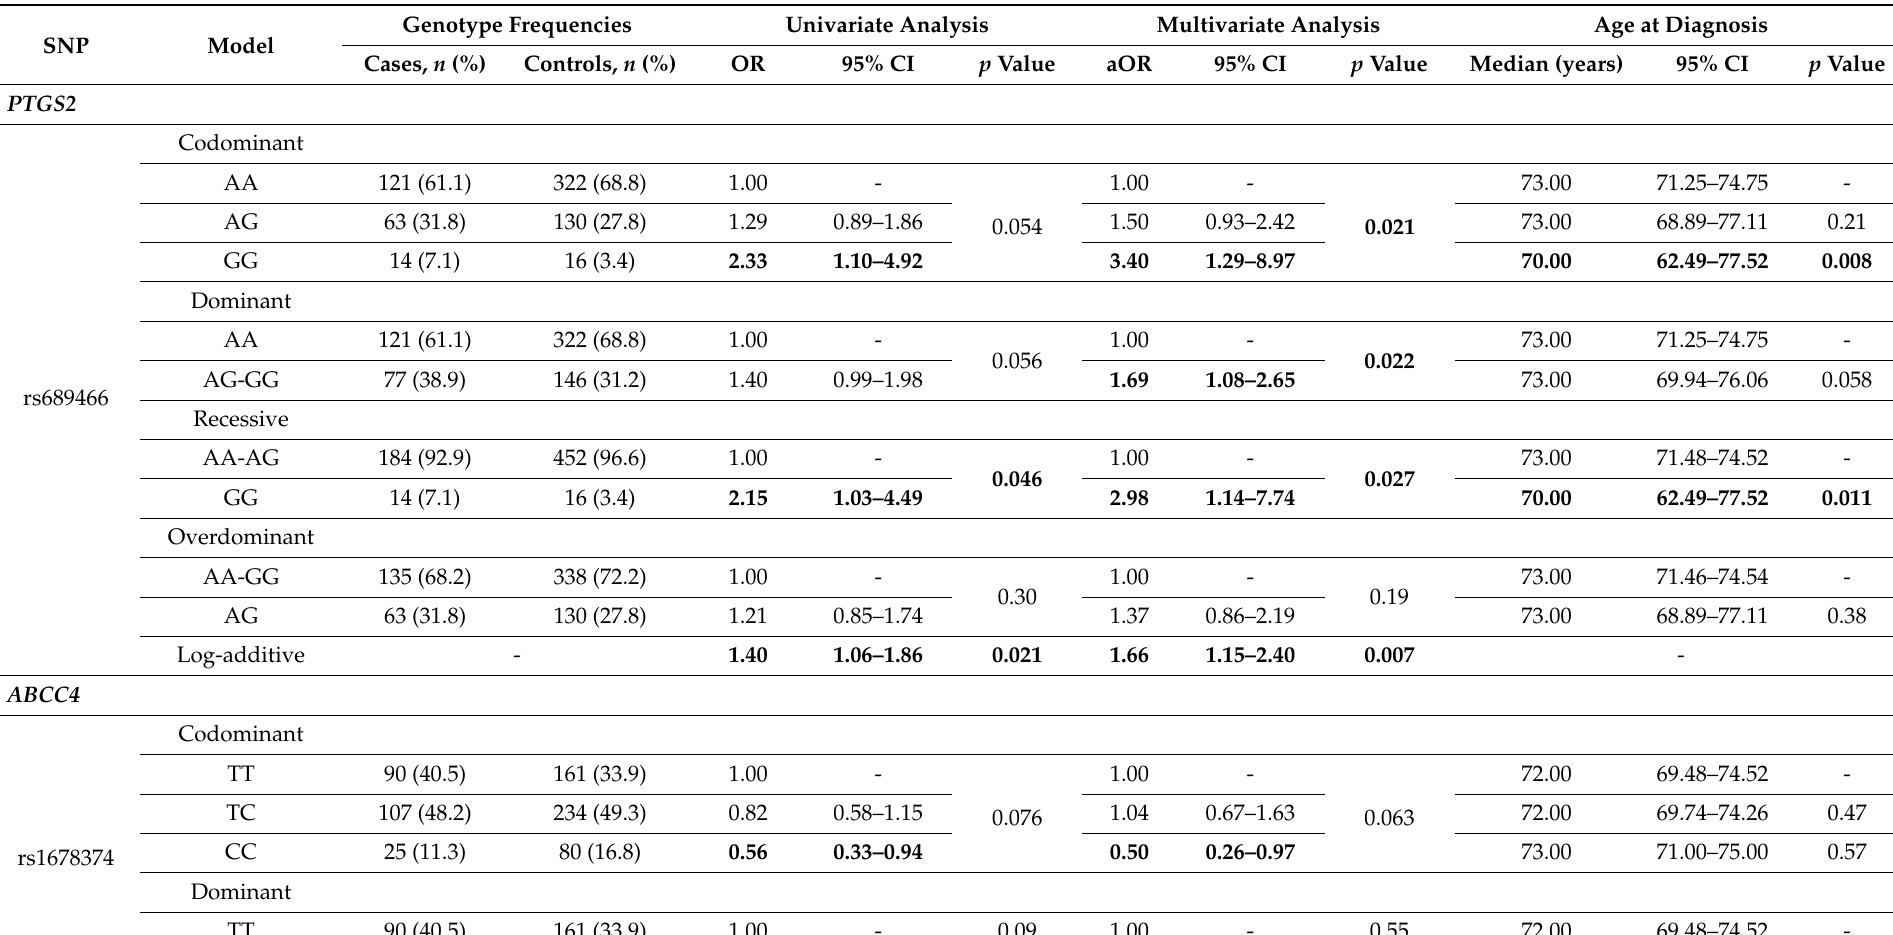
Table 2. Genotype frequencies among gastric cancer cases and controls, risk estimates for the involvement of PTGS2, ABCC4, HPGD, and SLCO2A1 genetic variants in gastric cancer onset and estimated age at